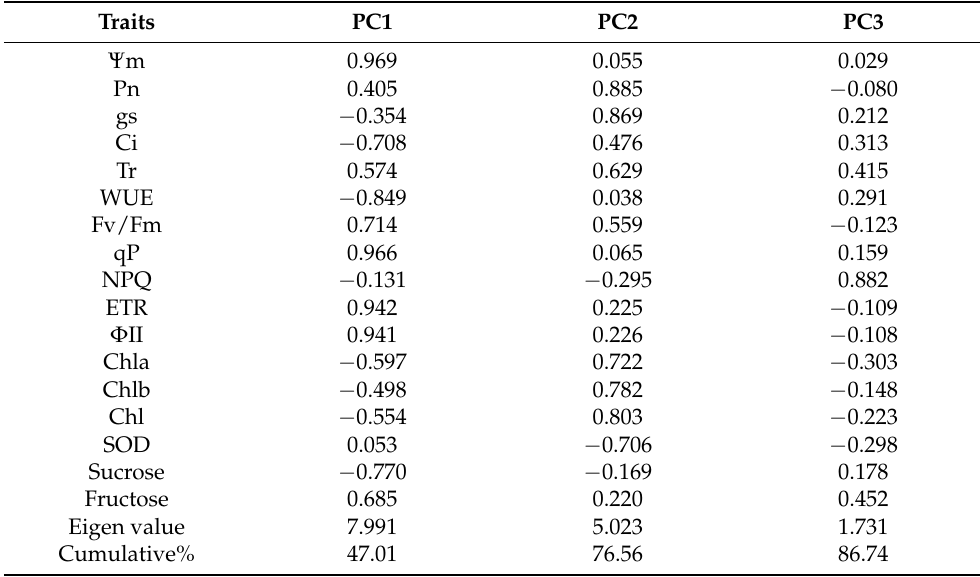
Table 3. Eigen vectors and eigen values of the first three principal components for different irrigation treatments. The numbers in bold indicate values of factor loading >